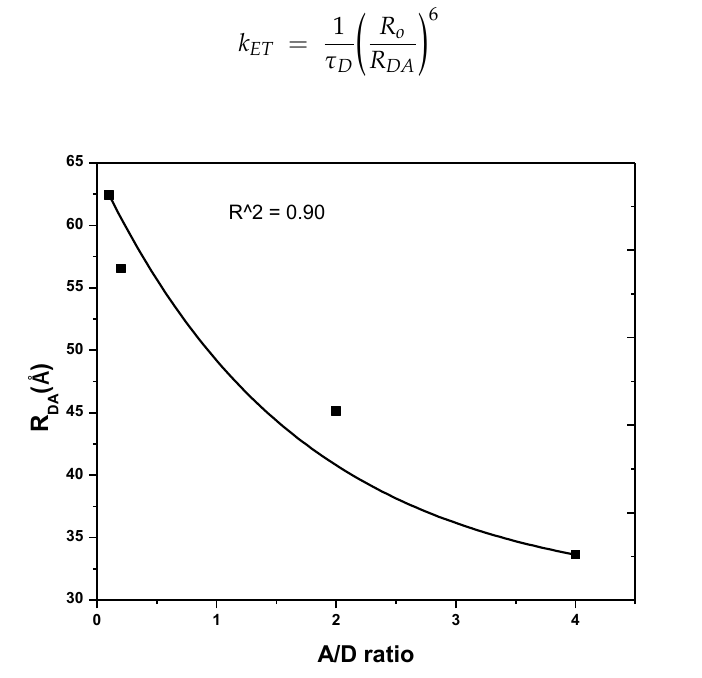
Figure 10. Energy transfer distance vis acceptor (A) / donor (D) ratio for 0-D Cs 4 PbBr 6 / MEH-PPV hybrid thin films.